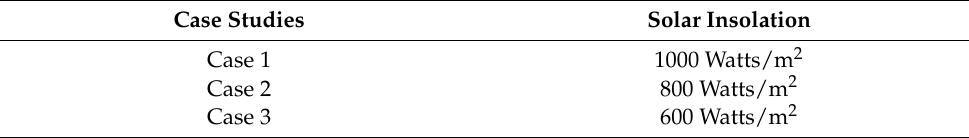
Table 6. Case Studies for PFR without any low-frequency fluctuation in the PFR envelope.